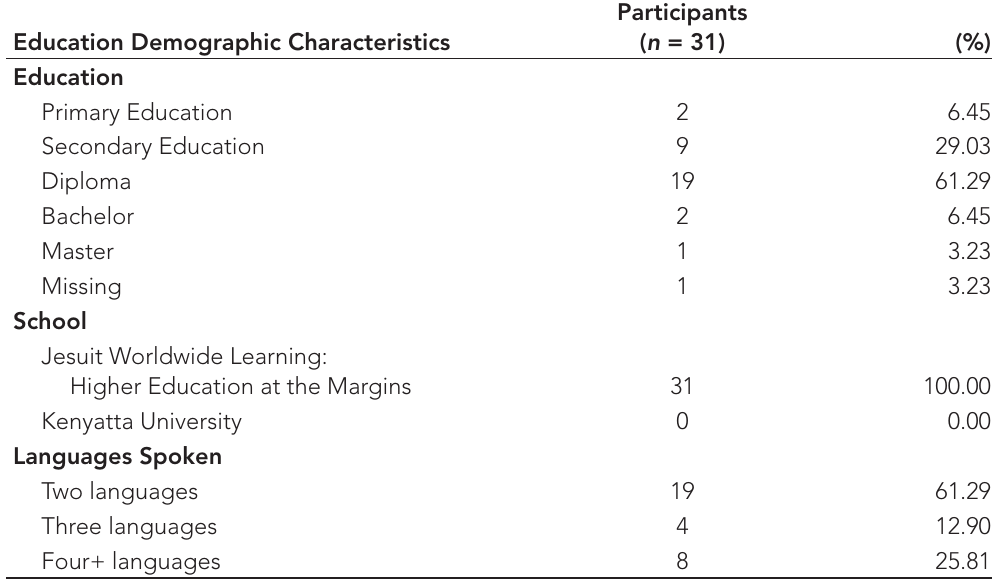
Table 3: Demographic Characteristics of Sample (Refugee camp) Education Demographic Characteristics